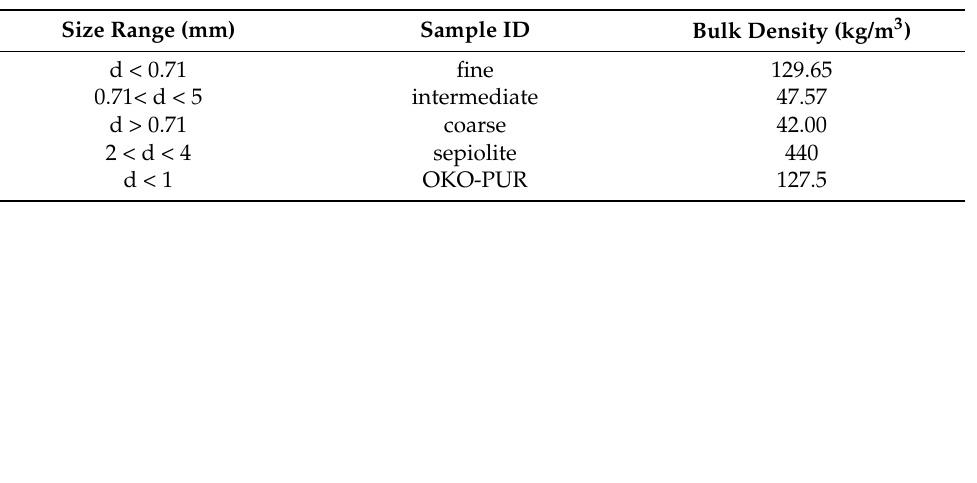
Table 1. Features of different types of samples used in oil sorption